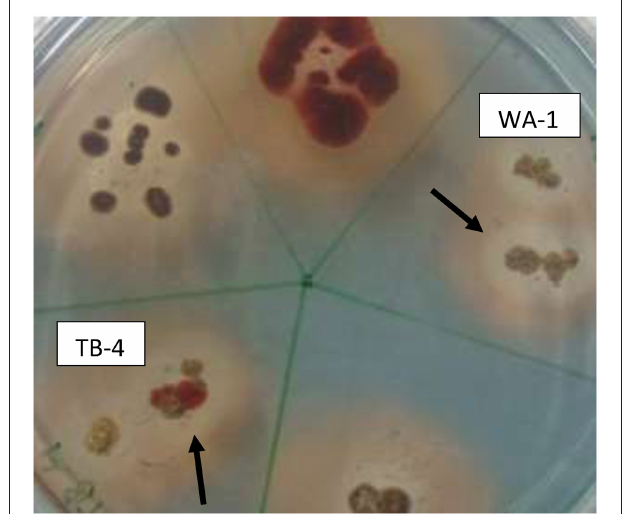
FIGURE 2 | Screening of siderophore producing actinomycete isolates using CAS agar plates after 7 days of growth at 28 ± 2 ◦ C. The arrows indicate the halo zone around the colonies of isolate WA-1 ( Streptomyces sp.) and TB-4 ( Streptomyces djakartensis ).